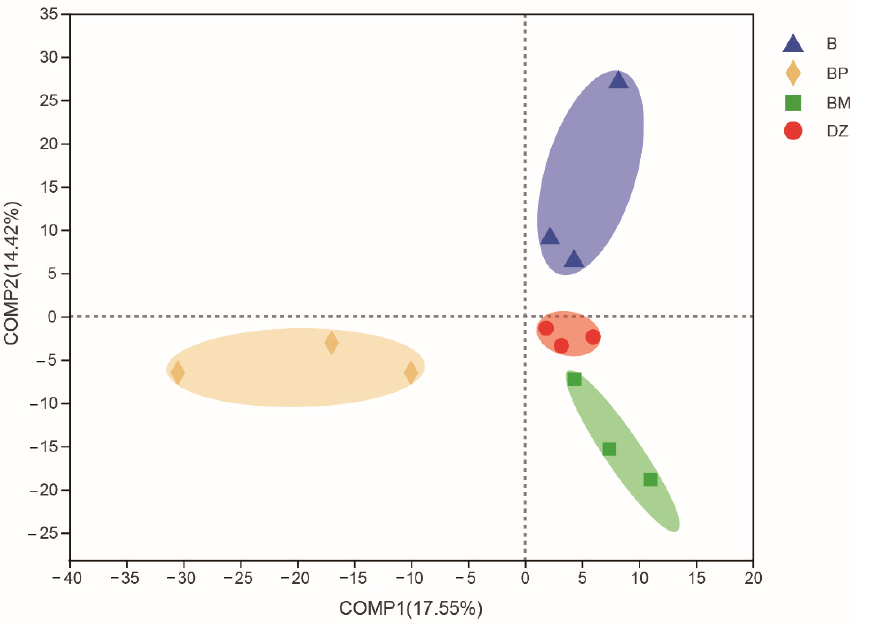
Figure 4. PLS-DA analysis based on OTU level of different P. vannamei culture systems. Note: group B, a single B. pumilus BP-171, was added; the group BP, B. pumilus BP − 171, and PHBV were